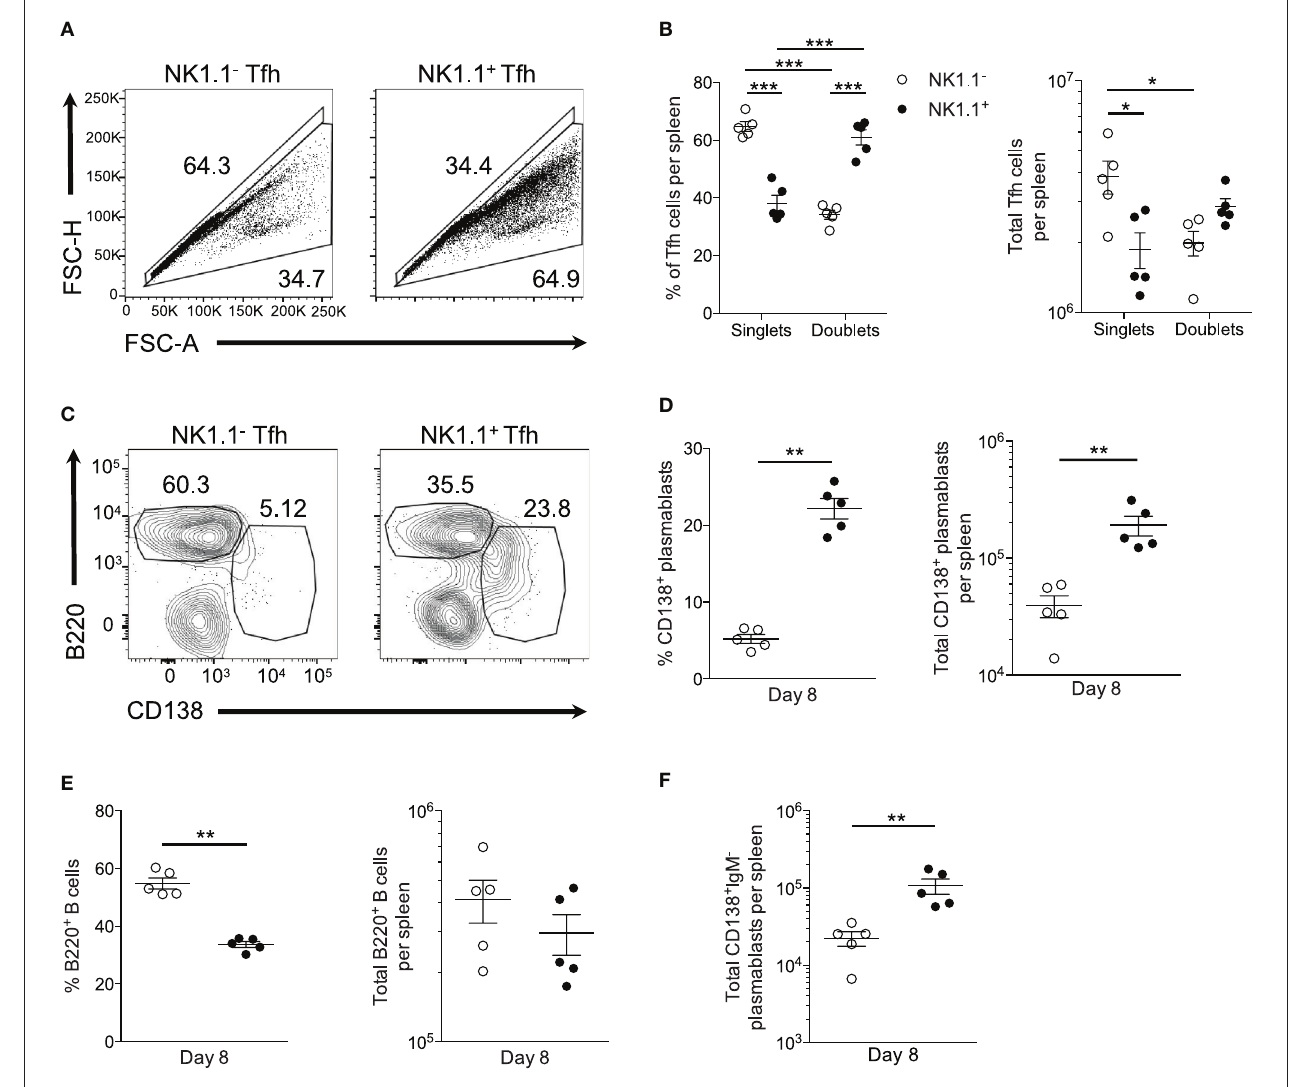
FIGURE 5 | NK1.1 + Tfh-like cells frequently complex with plasmablasts. (A) Gating strategy for doublet (FSC-A high FSC-H high ) and singlet (FSC-A low FSC-H low ) live NK1.1 positive or negative Tfh-like (CXCR5 + PD-1 + ) cells at day 8 post-infection. (B) Frequency and the total number of live singlet and doublet NK1.1 positive or negative Tfh-like cells per spleen at day 8 post-infection. An aligned rank transformation was performed on non-parametric data before determining significance by two-way ANOVA with a post hoc Holm-Sidak’s multiple comparisons test. * p < 0.05, *** p < 0.001. (C) Representative B220 and CD138 staining on live doublet NK1.1 negative or positive Tfh-like cells at day 8 post-infection. (D) Frequency and the total number of live CD138 + B220 lo plasmablasts interacting with NK1.1 negative or positive Tfh-like cells per spleen. (E) Frequency and the total number of live B220 + B cells interacting with NK1.1 negative or positive Tfh-like cells per spleen. (F) Total number of live class-switched IgM − CD138 + plasmablasts interacting with NK1.1 negative or positive Tfh-like cells per spleen. (D–F) Significance calculated by an unpaired nonparametric Mann-Whitney test. ** p < 0.01. Data are representative of three independent experiments (error bars,